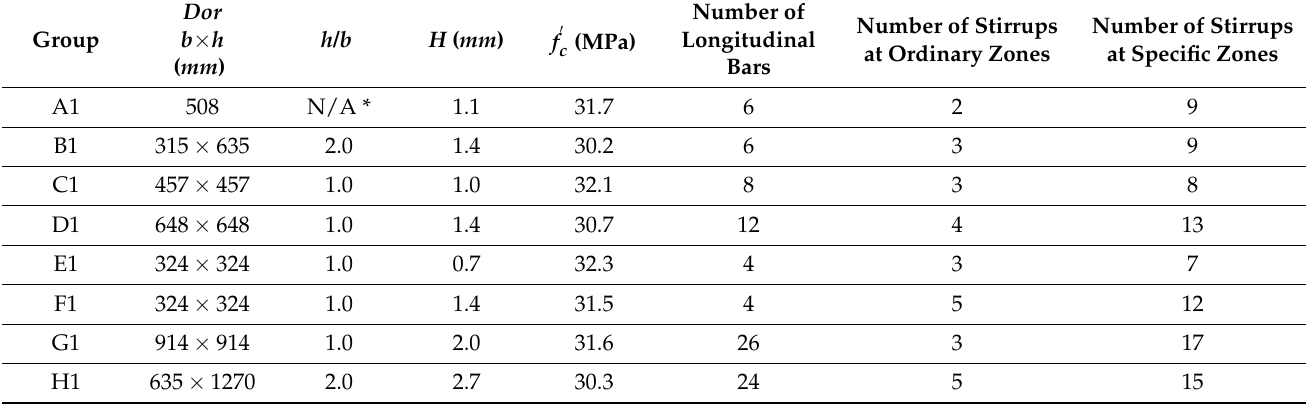
Figure 1. Geometry Properties of Reinforced Concrete Column, dimensions in mm. Table 1. Geometrical Properties of the experimental specimens.